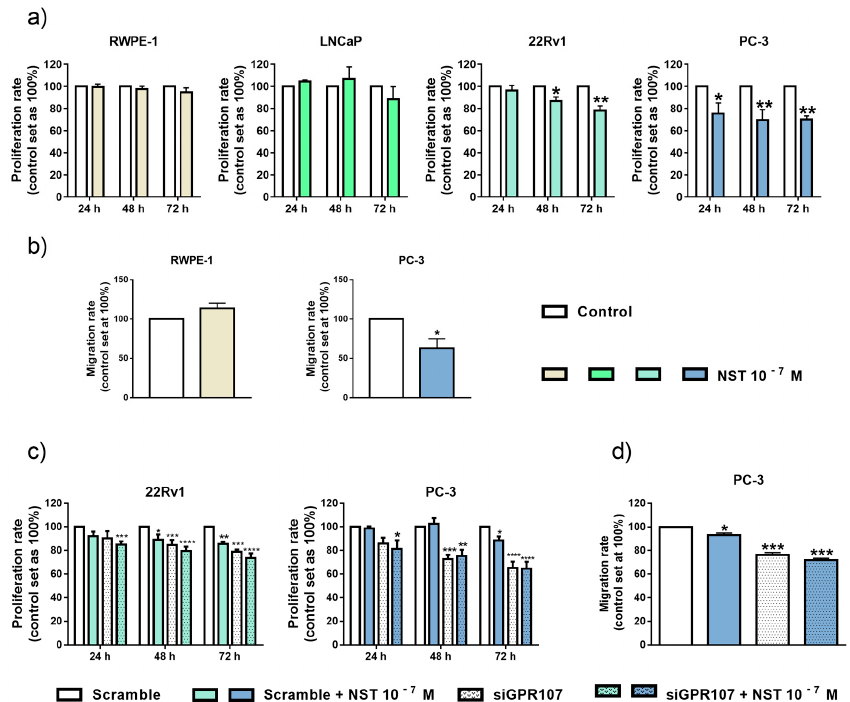
Figure 5. Functional e ff ects after neuronostatin (NST) treatment and after the combination of NST and G protein-coupled receptor 107 (GPR107)-silencing treatment in prostate cell lines. ( a ) Proliferation rate of normal prostate (RWPE-1) and Prostate Cancer (PCa) (LNCaP, 22Rv1 and PC-3) cells in response to NST treatment (10 –7 M; after 24, 48 and 72 h). ( b ) Migration rate of normal prostate (RWPE-1) and PCa (PC-3) cells after 24 h of NST treatment (10 –7 M). Proliferation ( c ) and migration ( d ) rate of androgen-independent PCa cells in response to NST and GPR107-silencing alone or in combination. Data were represented as percent of vehicle-treated cells (set at 100%). Asterisks (* p < 0.05; ** p < 0.01 and *** p < 0.001) indicate statistically significant di ff erences between groups. siGPR107: small interferent RNA against